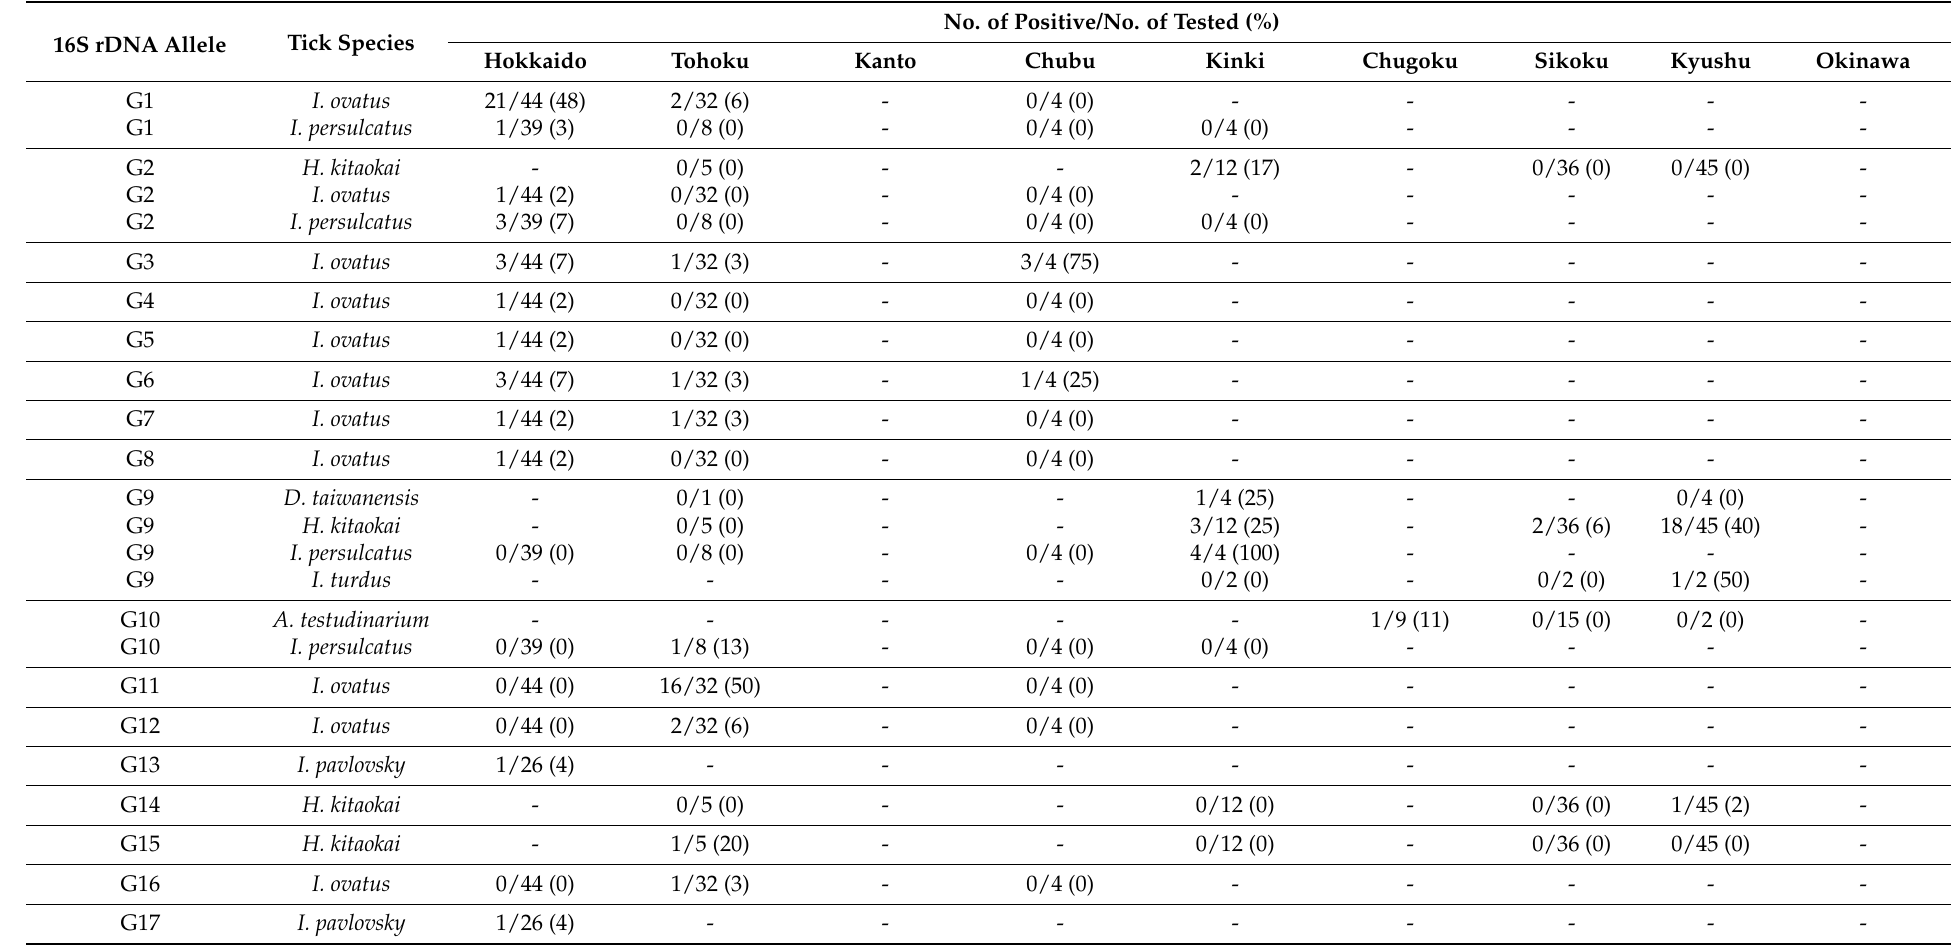
Table 2. Spiroplasma 16S rDNA alleles and their geographic origins and host tick